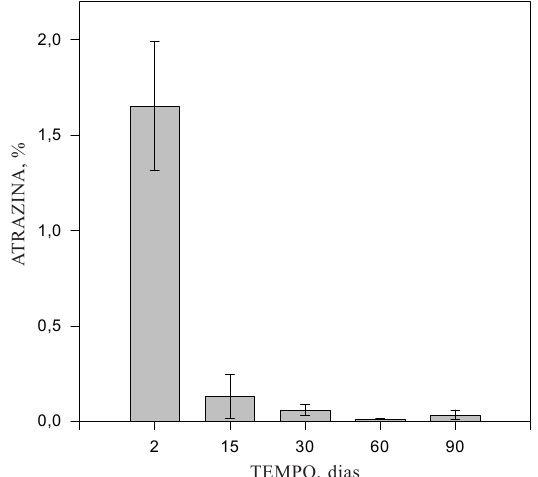
Figura 7. Percentagem de atrazina na água do escorrimento superficial. As barras verticais indicam o desvio-padrão (três